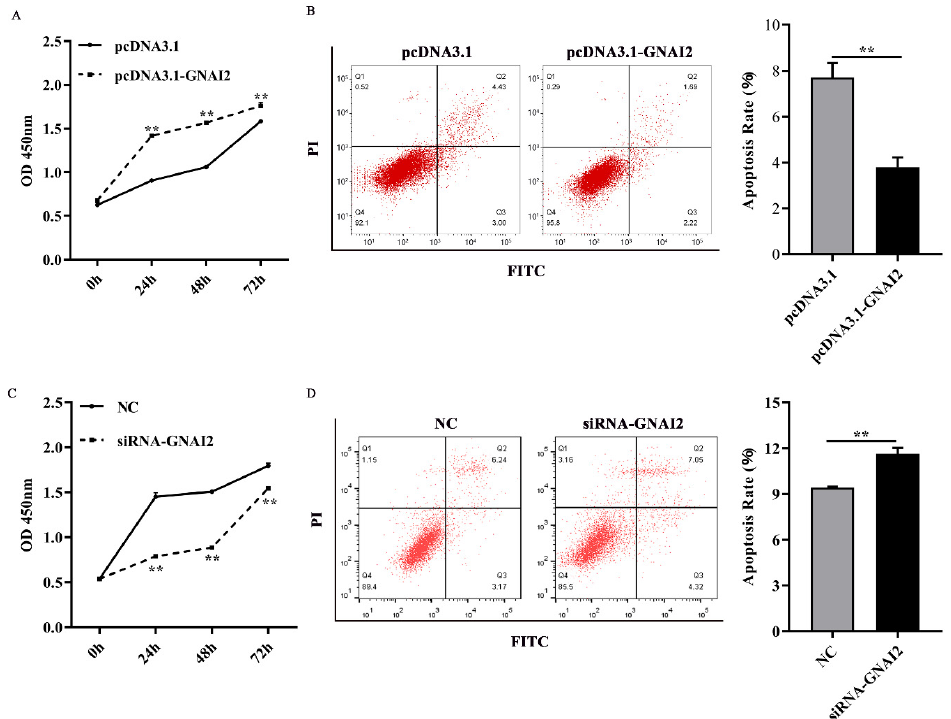
Figure 4. GNAI2 regulated melanocyte proliferation and apoptosis: ( A ) melanocyte proliferation was estimated using CCK-8 assay at 24, 48, and 72 h in GNAI2-overexpressing melanocytes; ( B ) melanocyte apoptosis was detected in GNAI2- overexpressing melanocytes and cellular apoptosis rate was calculated; ( C ) melanocyte proliferation was estimated in GNAI2-silenced melanocytes at 24, 48, and 72 h using the CCK-8 assay; ( D ) cellular apoptosis of GNAI2-silenced melanocytes was measured and cellular apoptosis rate was calculated. Samples were in triplicates. **, p < 0.01. 3.5. GNAI2 Overexpression and Knockdown Regulated the Expression of Melanin ‐ 216 Related Genes 217